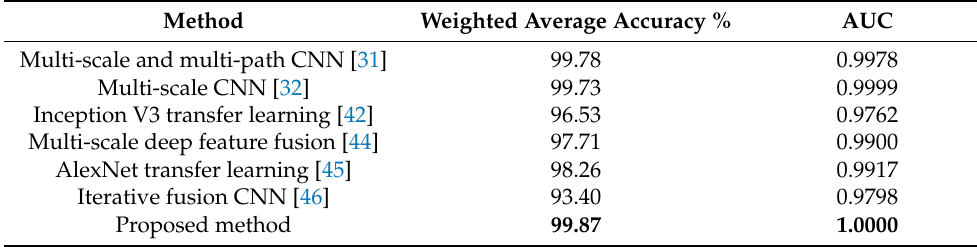
Table 4. Comparison of the proposed method with existing works conducted on the UCSD